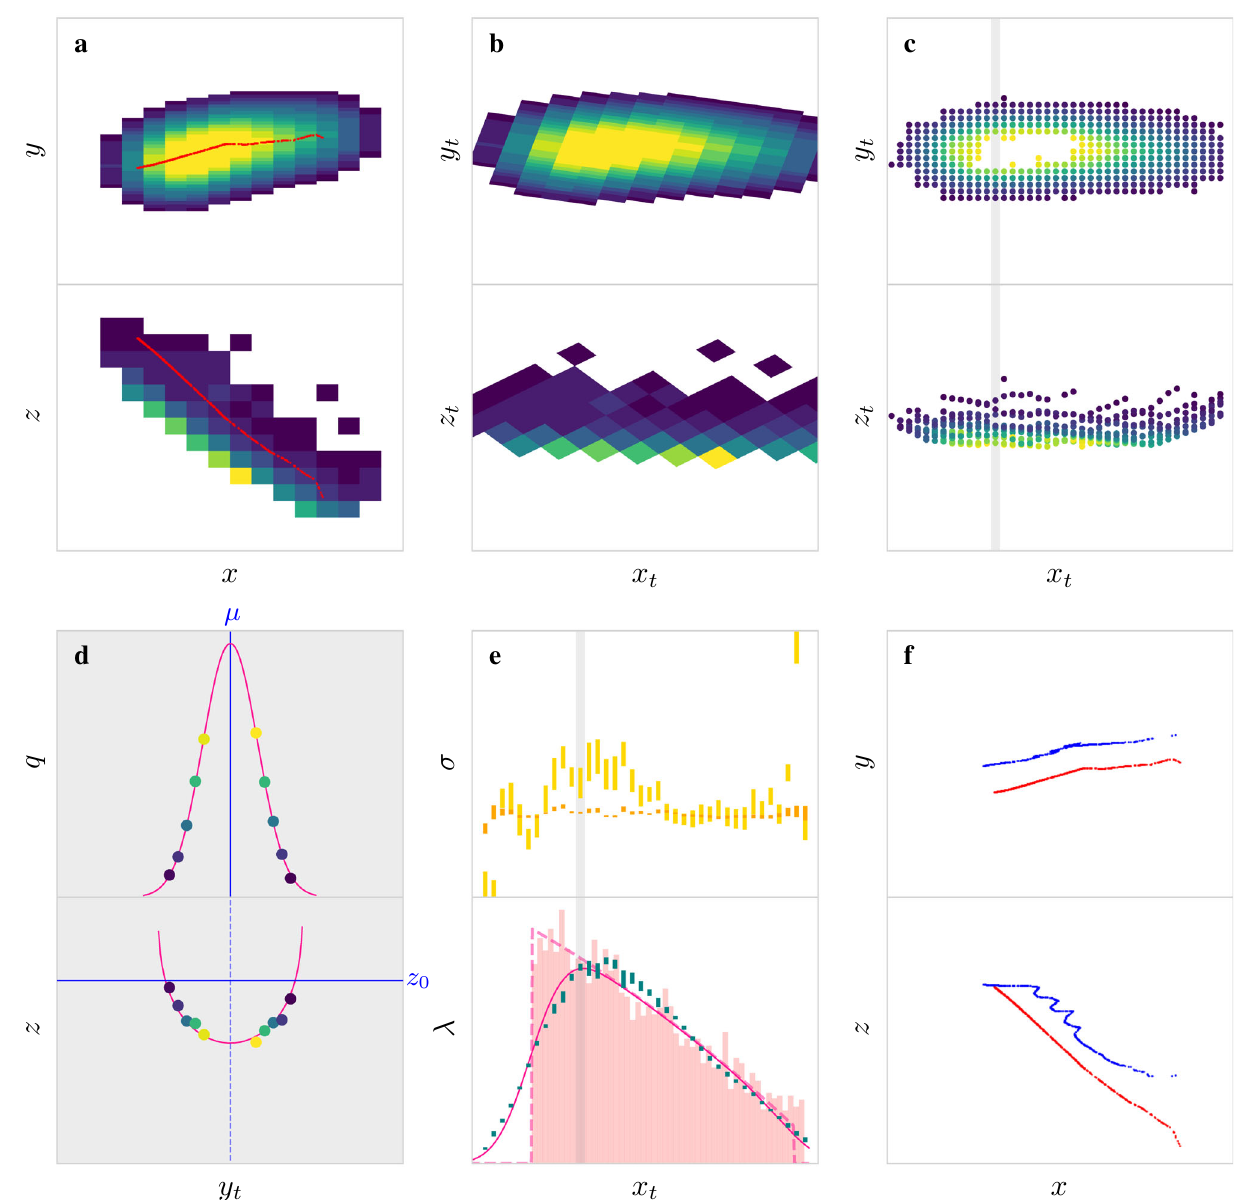
Fig. 6 An illustration of the ptr algorithm using one simulated 200 keV recoil. Panel labels ( a – c ) correlate to section labels explaining each step. Each spatial dimension ( x , y , z , x t , y t , z t ) is equal in span (roughly 1 cm). Colors indicate the primary track (red), fitted parame- ters (blue), and fitted functions (magenta). The color/intensity scale in all 2D histograms encodes charge density with lighter colors indicating higher densities. The panels show, in order: a the primary track (red dots) projected on the chip coordinates x , y , z , overlaid on top of the digitized signal. b The digitized tracks rotated into the “track” coordi- nates x t , y t , z t ,obtainedviatheSVDprefit. c Samples(rows) organized byslice(columns).Abilinearinterpolationestimates q foreachsample, shown by color/shade. The vertical gray bar indicates a single slice that